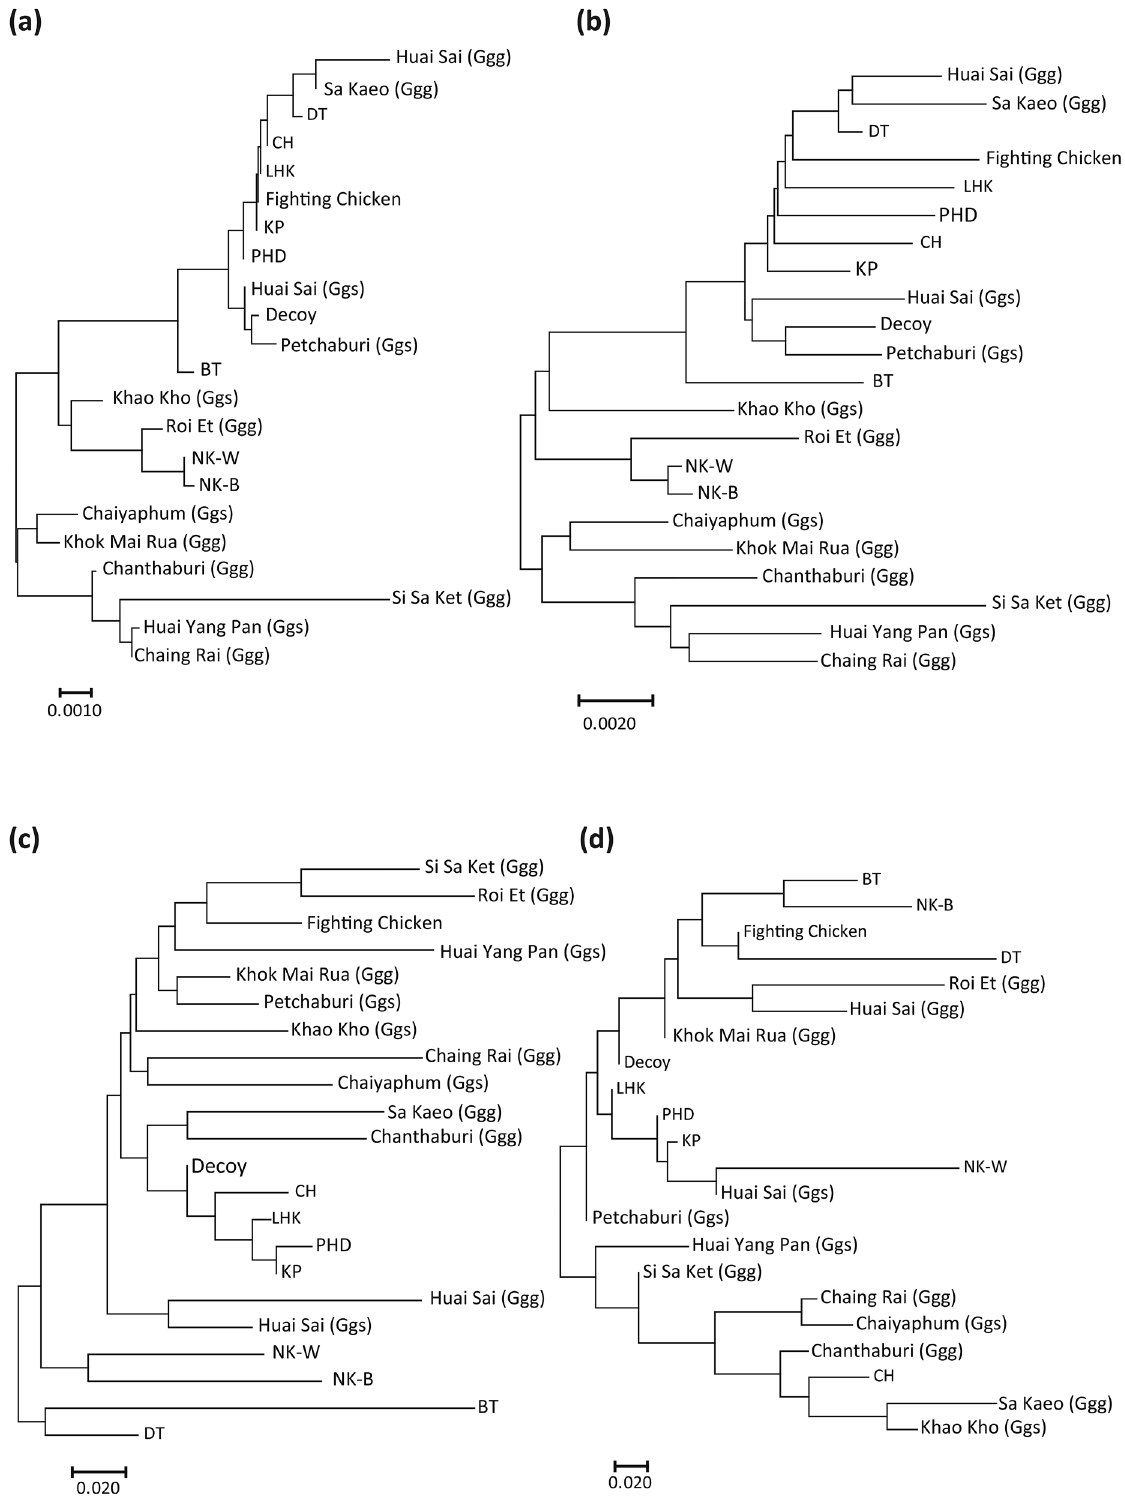
Figure 4. Neighbour-joining trees of 10 indigenous chicken breeds and 12 red junglefowl populations in Thailand constructed using mtDNA D-loop sequences and microsatellite markers. Neighbour-joining trees were constructed using Nei’s genetic distance according to allele frequencies ( Da ) ( a ) and the genetic distance based on nucleotide substitution per site ( Dxy ) ( b ) using mtDNA D-loop sequences and according to pairwise F ST distance ( c ) and pairwise R ST distance ( d ) using 28 microsatellite